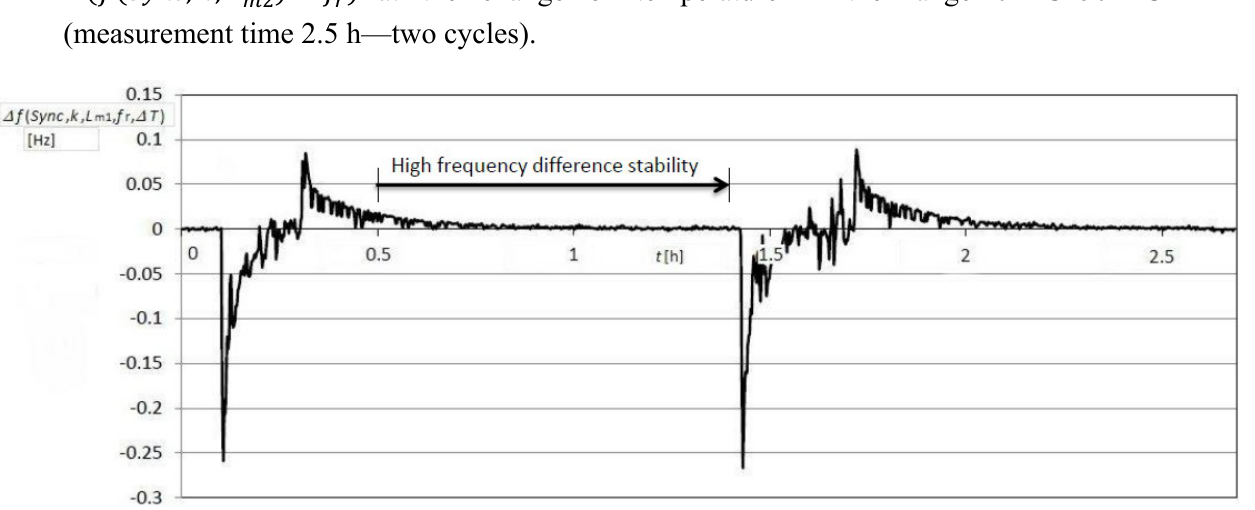
(cid:4667) (cid:3398) (cid:1858) (cid:4667) (cid:3397) ∆(cid:1838) (cid:3040)(cid:2869) (cid:3040)(cid:2869) (cid:3045)